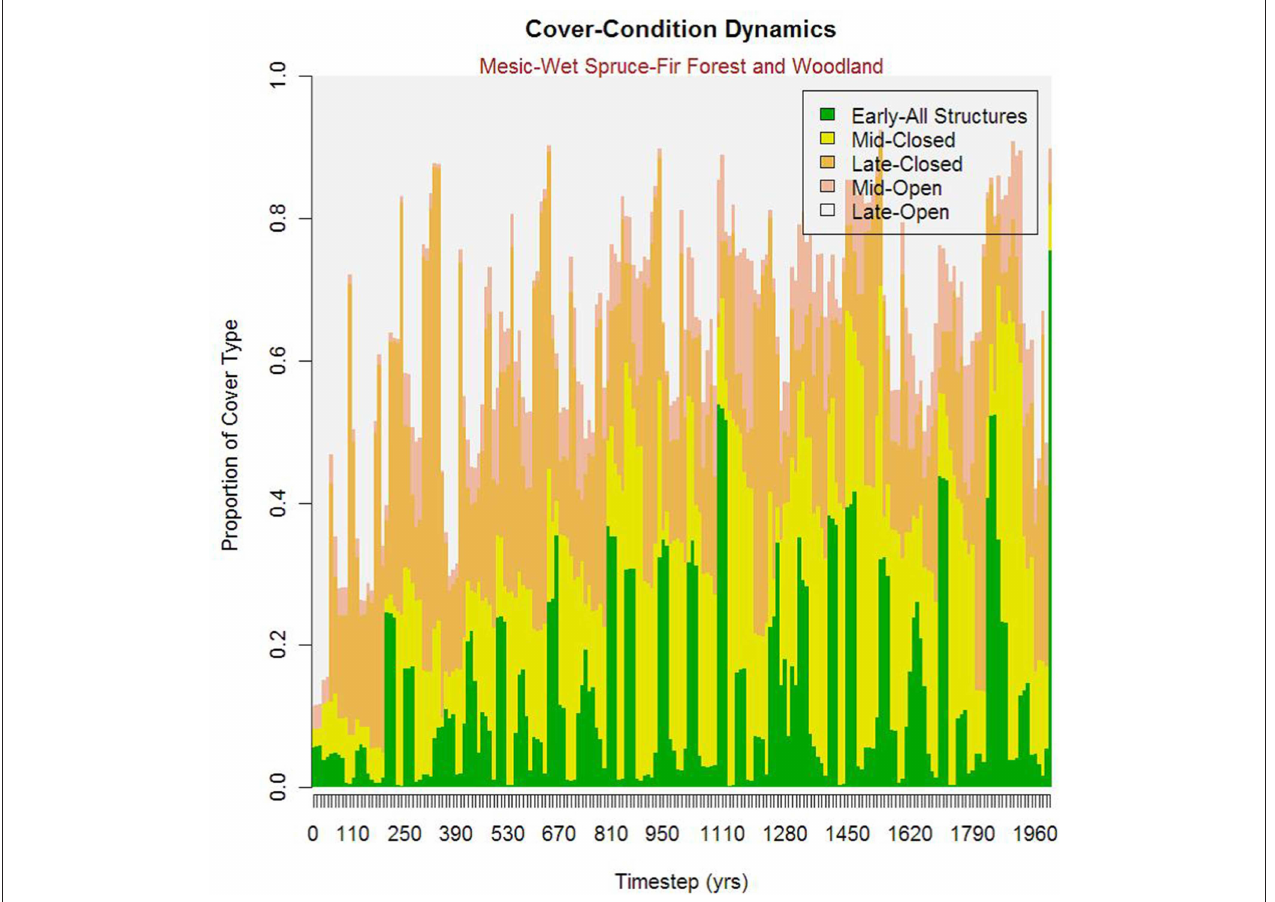
FIGURE 5 | Temporal plot of proportion of the Prospect Creek landscape covered by each of the different seral stages of one focal vegetation cover type, Mesic-Wet Spruce-Fir Forest and